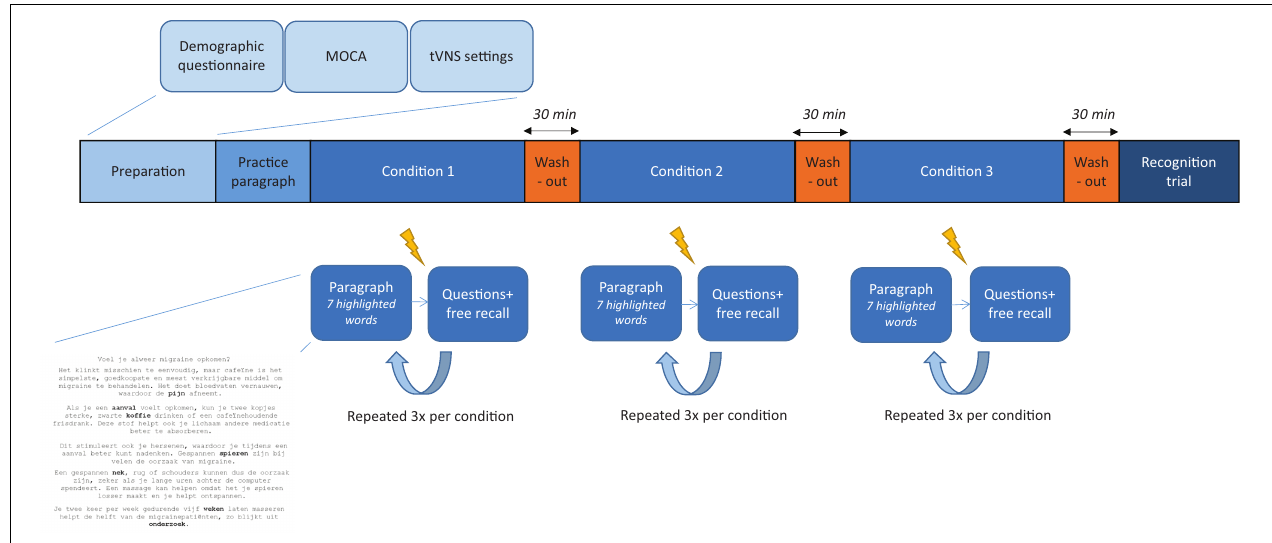
FIGURE 1 | Overview of the study. After preparation of the experimental session and one practice paragraph, the word recognition memory paradigm is conducted. Three experimental conditions are used, separated by a washout period of 30 min. Stimulation ( ) is delivered 2 min after reading a paragraph and followed by two questions and a free recall task. This is repeated three times per condition. At the end of the paradigm, participants perform a recognition test.